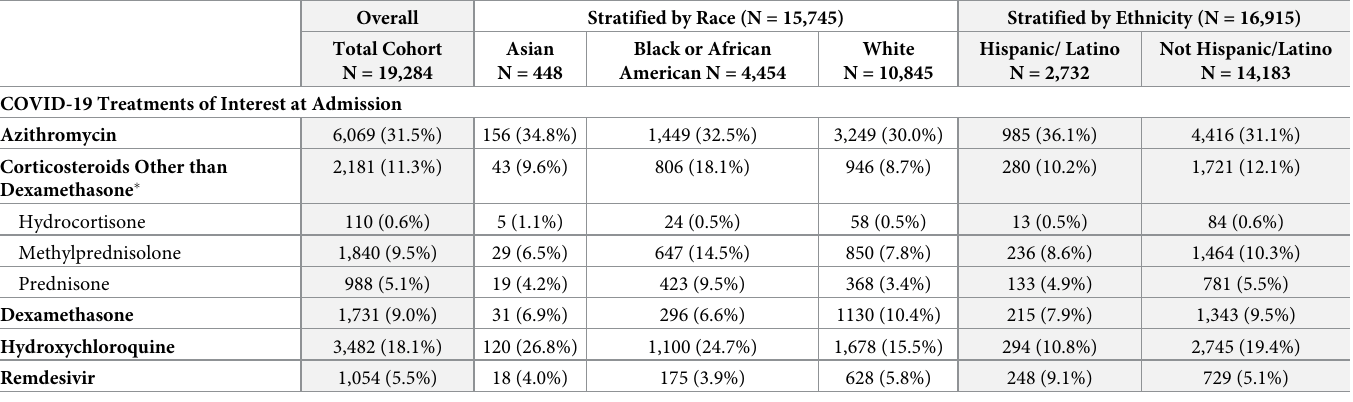
Table 2. COVID-19 treatments received at admission by race, and by